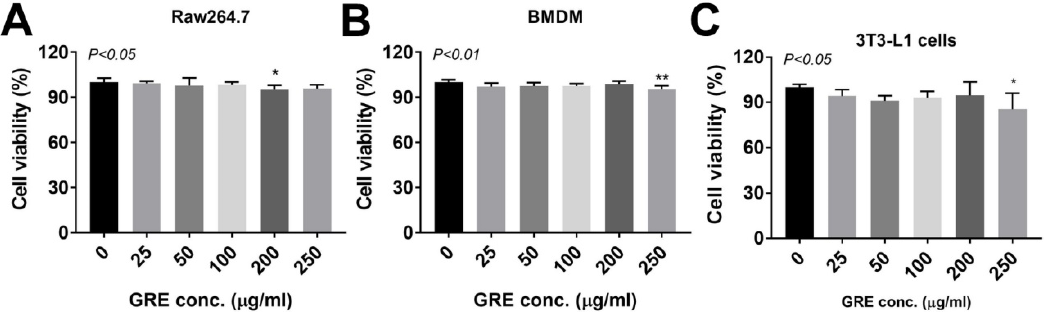
Figure 1. E ff ects of cultured ginseng roots (GR) extract on cell viability in RAW264.7, mouse bone- marrow-derived macrophages (BMDM), and 3T3-L1 pre-adipocytes. The culture of ( A ) RAW264.7, ( B ) BMDM, and ( C ) 3T3-L1 were treated with 25–250 µ g / mL of GRE for 24 h. 2,3-Bis-(2-Methoxy-4-Nitro- 5-Sulfophenyl)-2H-Tetrazolium-5-Carboxanilide (XTT) reagent was added 3 h before measurement of OD 450nm. Data are expressed as percentages of the vehicle control (dimethyl sulfoxide (DMSO)). Data are represented as the mean ± SEM of three independent experiments ( n = 8 / group for each experiment); * p < 0.05; ** p < 0.01; compared with vehicle vs. GRE-treated group by one-way ANOVA with Bonferroni’s comparison test.